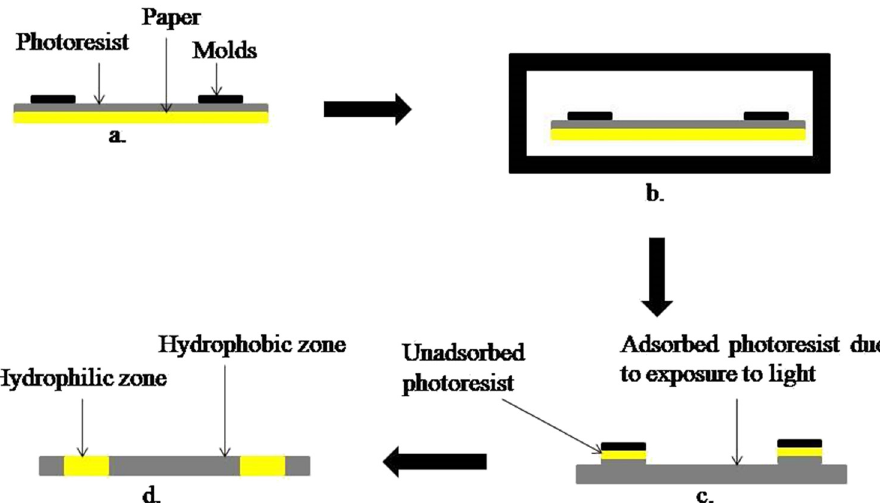
Figure 3: Photolithographic fabrication procedure: ( a ) paper, photoresist polymer, and moulds are held together, ( b ) exposure to radiation is done in contained chamber, ( c ) photoresist gets adsorbed in the areas exposed to radiation and unexposed region is left itself as such, and ( d ) completely fabricated PAD.